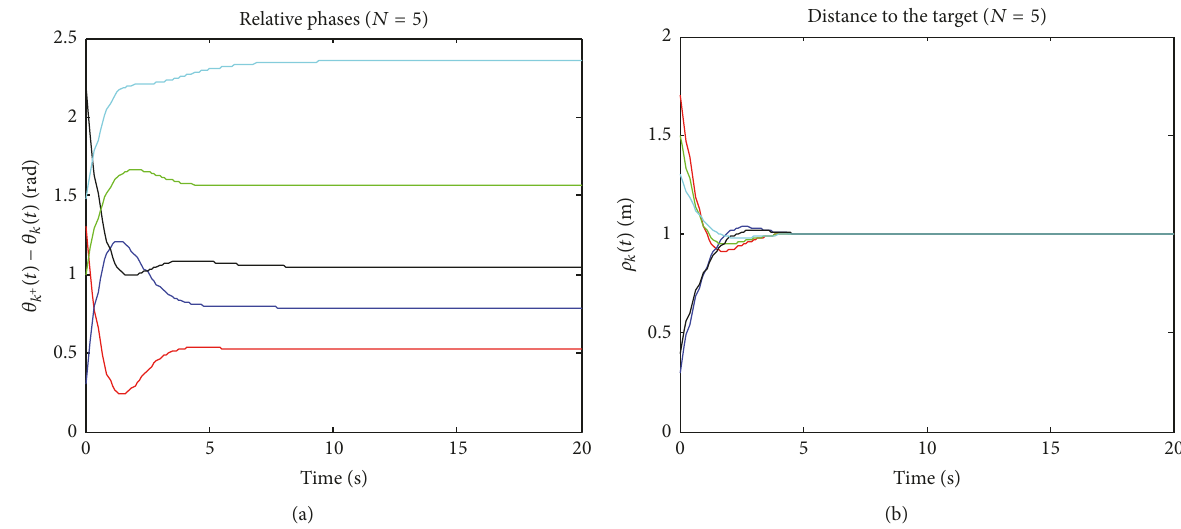
Figure 4: Trajectories with time of Figure 3. (a) Relative phases 𝜑 𝑘 + 𝑘 (𝑡) . (b) Distances to the target.